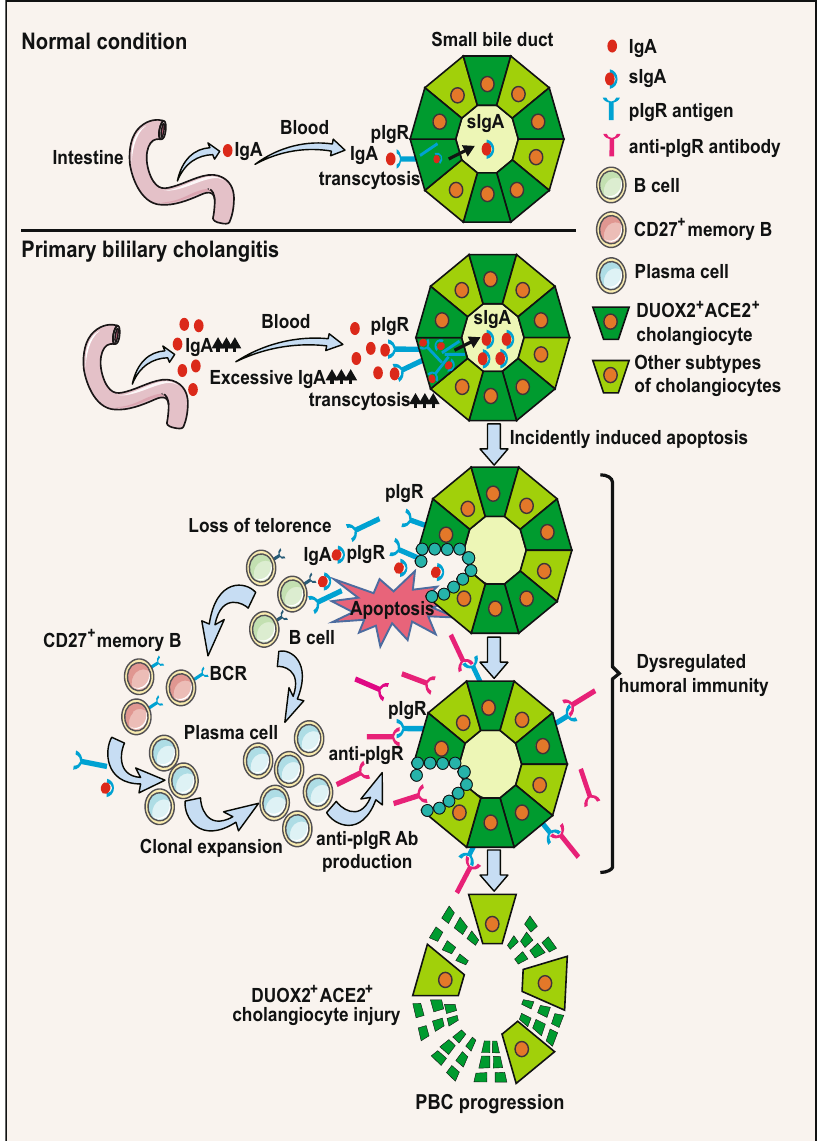
Fig. 7 | A proposed immunologicalmechanismunderlying thepathogenesisof PBC. Initially, excessive IgA undergo transcytosis through the pIgR into DUOX2 + - ACE2 + small cholangiocytes and incidentally induce cholangiocyte